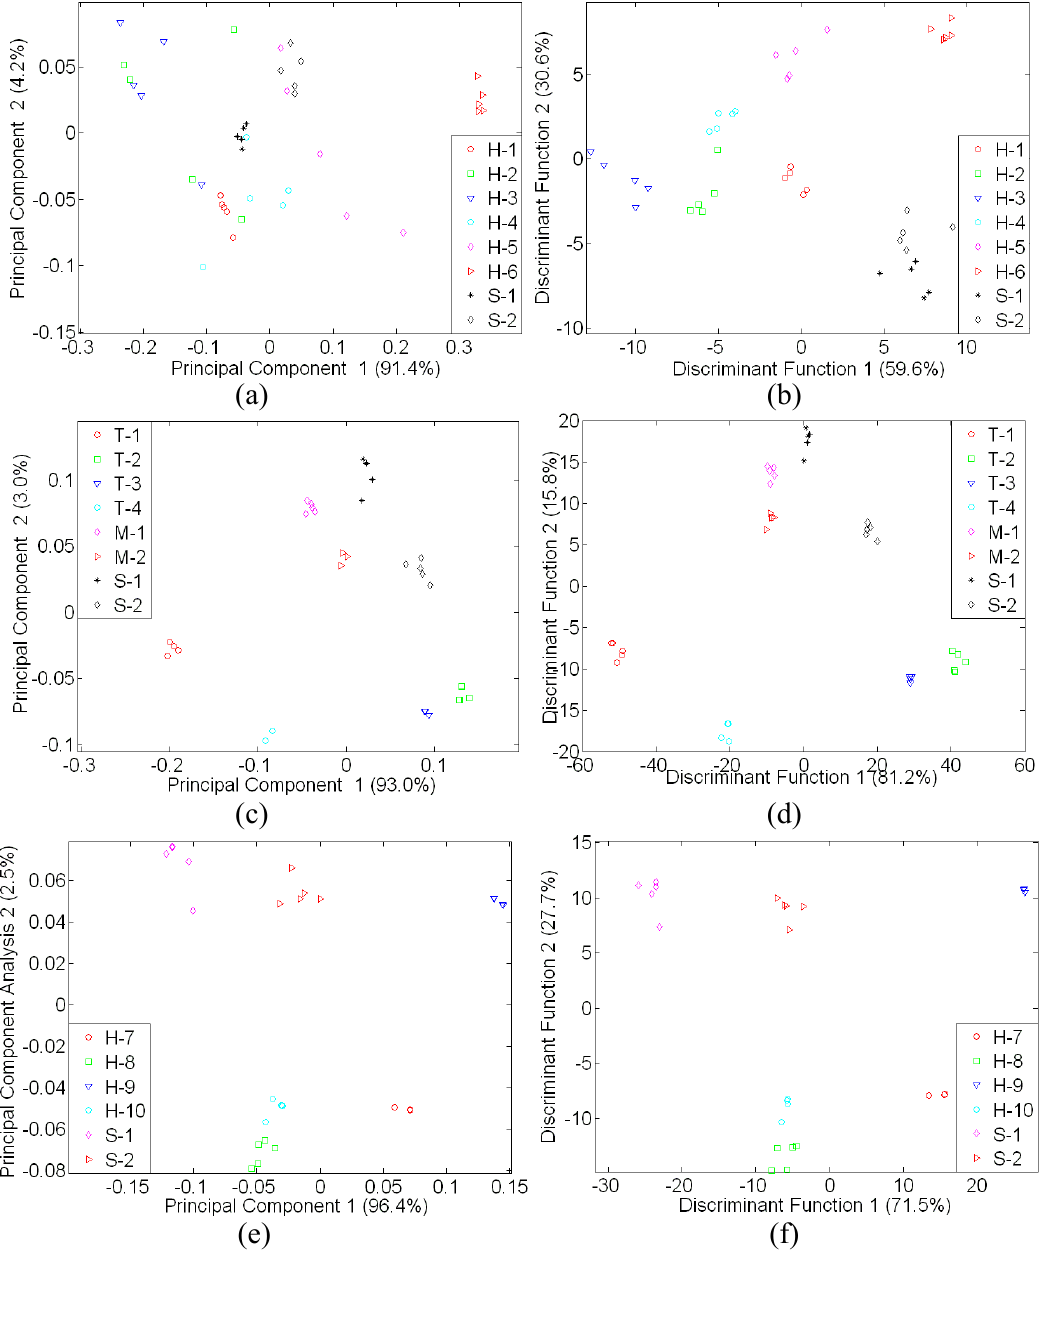
Figure 6. Separate plot of 7 e-tongue sensors on honey assessment: ( a ) PCA plot of Leaf, Durian, Malaluka, Coconut, Starfruit, Wax Apple Honey, Nona and Bunga Raya, ( b ) LDA plot of Leaf, Durian, Malaluka, Coconut, Starfruit, Wax Apple Honey, Nona and Bunga Raya, ( c ) PCA plot of four different brands of Tualang Honey, Nona, Bunga Raya and two adulterated samples, ( d ) LDA plot of four different brands of Tualang Honey, Nona, Bunga Raya and two adulterated samples, ( e ) PCA plot of four different floral origin of New Zealand honey, Nona and Bunga Raya and ( f ) LDA plot of four different floral origin of New Zealand honey, Nona and Bunga